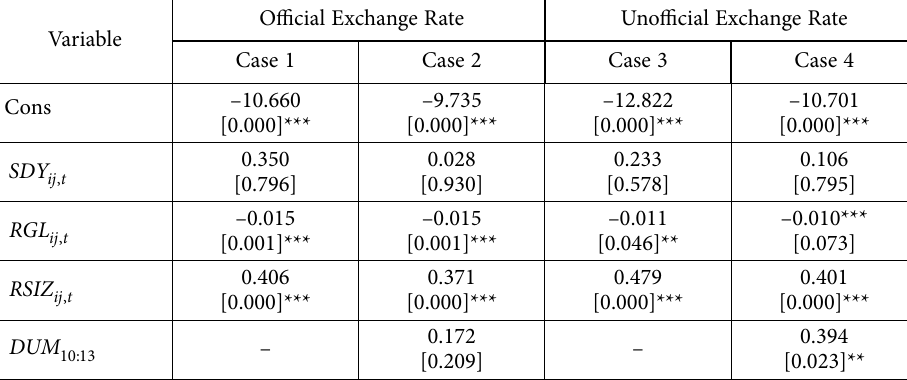
Table 2. Empirical results of bilateral exchange rate volatility model Eq. (1) and Eq. (2) (source: own research)